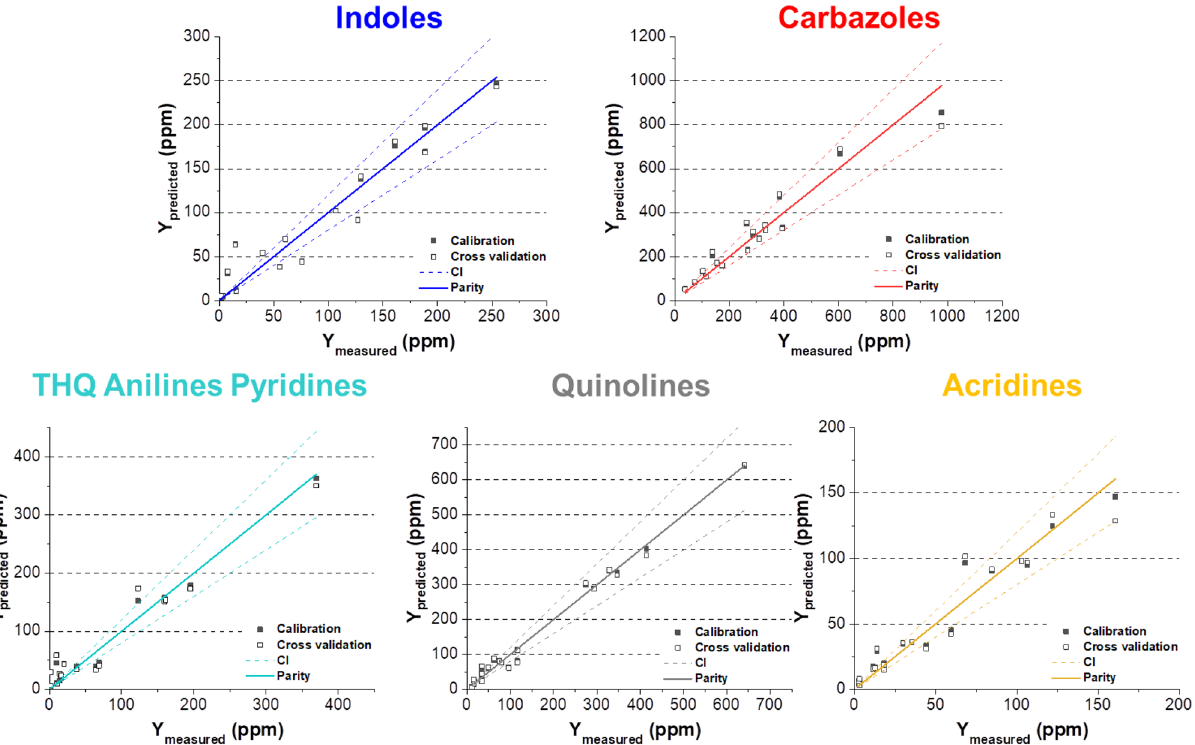
Figure 4. Parity diagrams showing the predicted Y value as a function of the measured Y value obtained from MLR